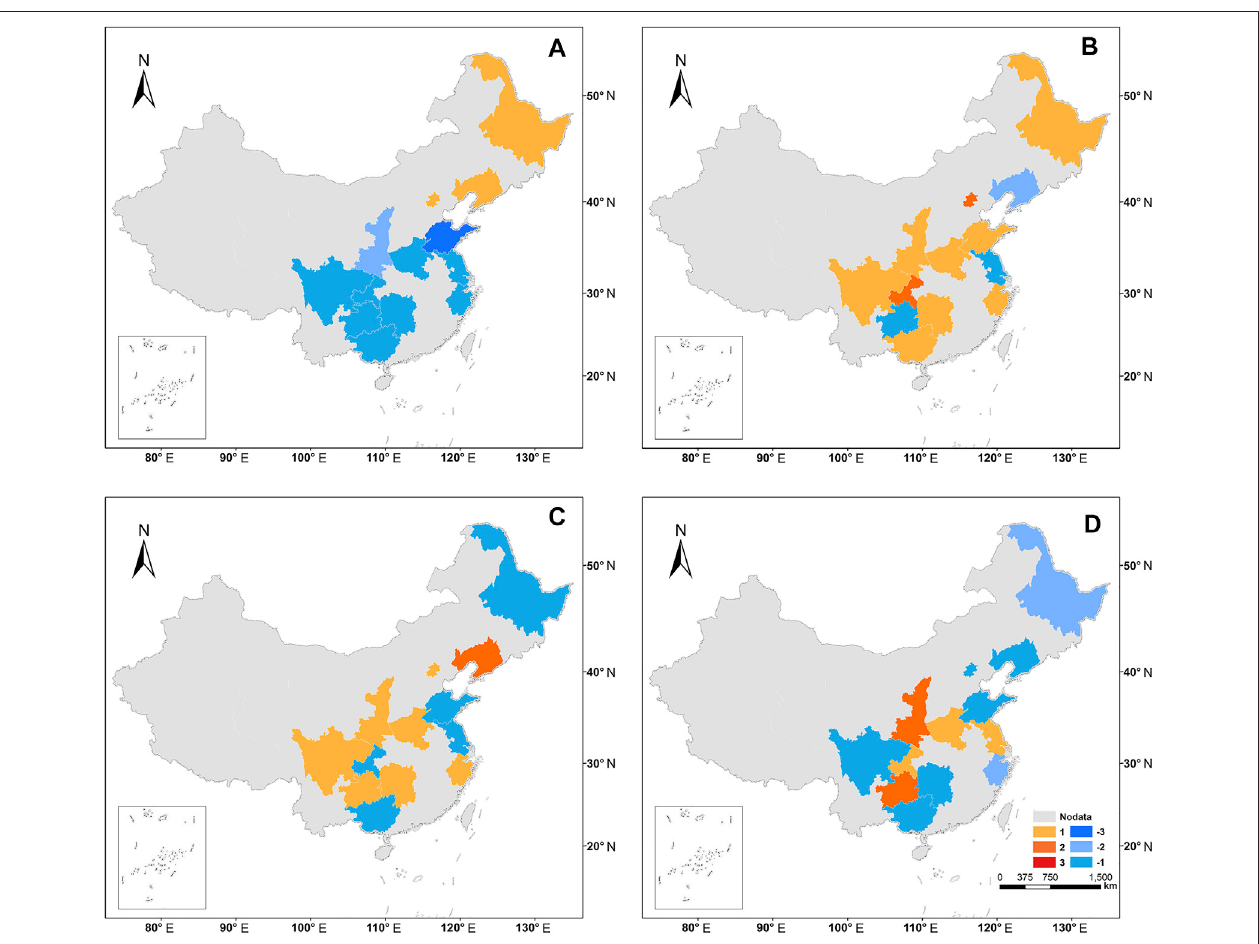
FIGURE7| Theeffectofthepreseasonclimateonthegerminationstageandthewiltingstage.Orangeisnegative,andgreenispositive. (A) Thespatialdistribution ofcorrelation betweenpreseason temperature andgerminationstage. (B) Thespatialdistribution ofcorrelation betweenpreseason precipitation andgerminationstage. (C) The spatial distribution of correlation between preseason temperature and the wilting stage, and (D) the spatial distribution of correlation between preseason precipitation and wilting stage. The light gray areas in the fi gures represent the areas with no data. The blue area represents the declining trend, while the red area represents the increasing trend, and the color from light to dark indicates the increasing of signi fi cance ( ± 1: p > 0.05, ± 2: p < 0.05, ± 3: p < 0.01).